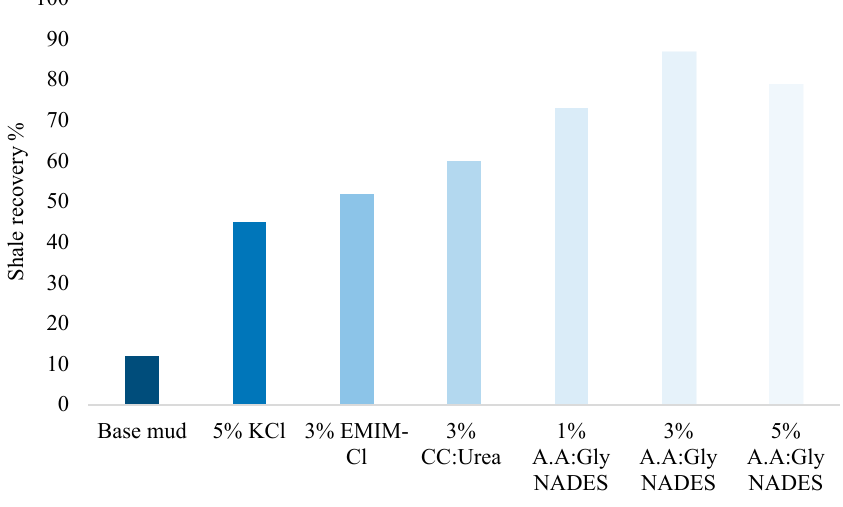
Figure 8. Shale recovery caused by various inhibitors in drilling mud.